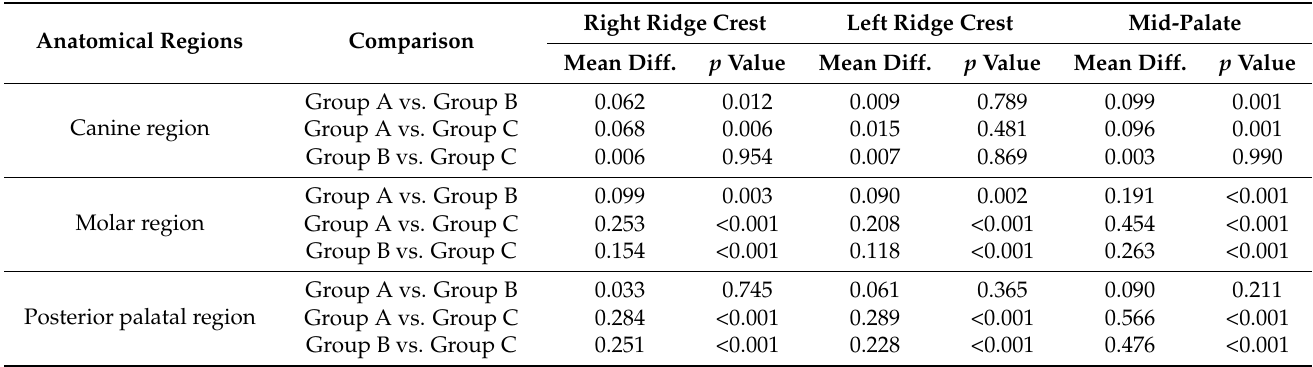
Table 1. For each site of canine region, comparisons of difference in mean dimensional discrepancy (mm) between groups by Tukey test at 12